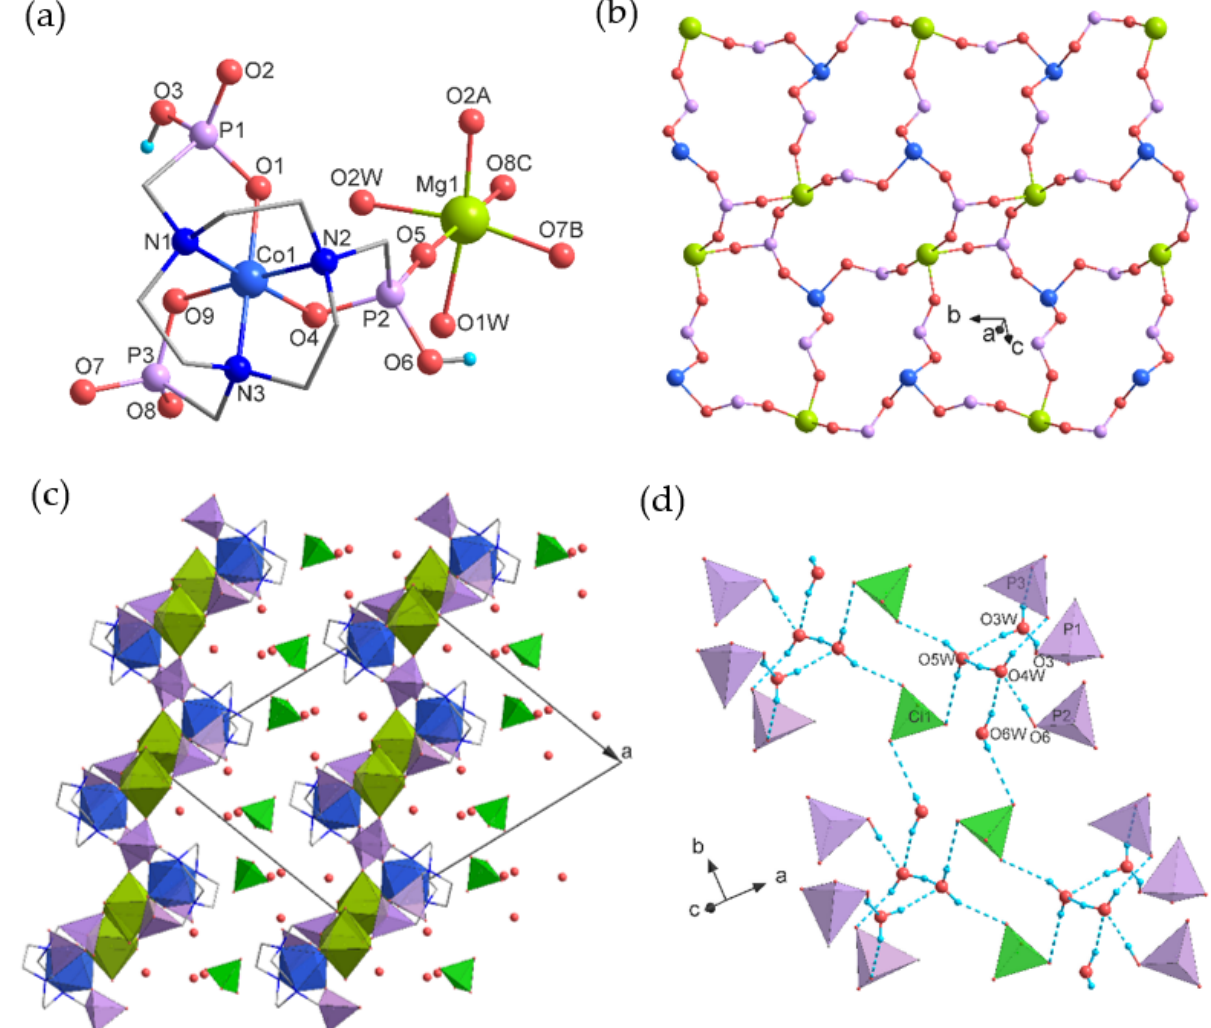
Figure 2. The crystal structure of CoMg · 4H 2 O ; the asymmetric unit ( a ), one inorganic layer ( b ), the three-dimensional packing diagram ( c ), and hydrogen chains composed of lattice water molecules, phosphonate groups, and perchlorate anions ( d ). All hydrogen atoms are omitted for clarity, except in the protonated phosphonate groups or the water